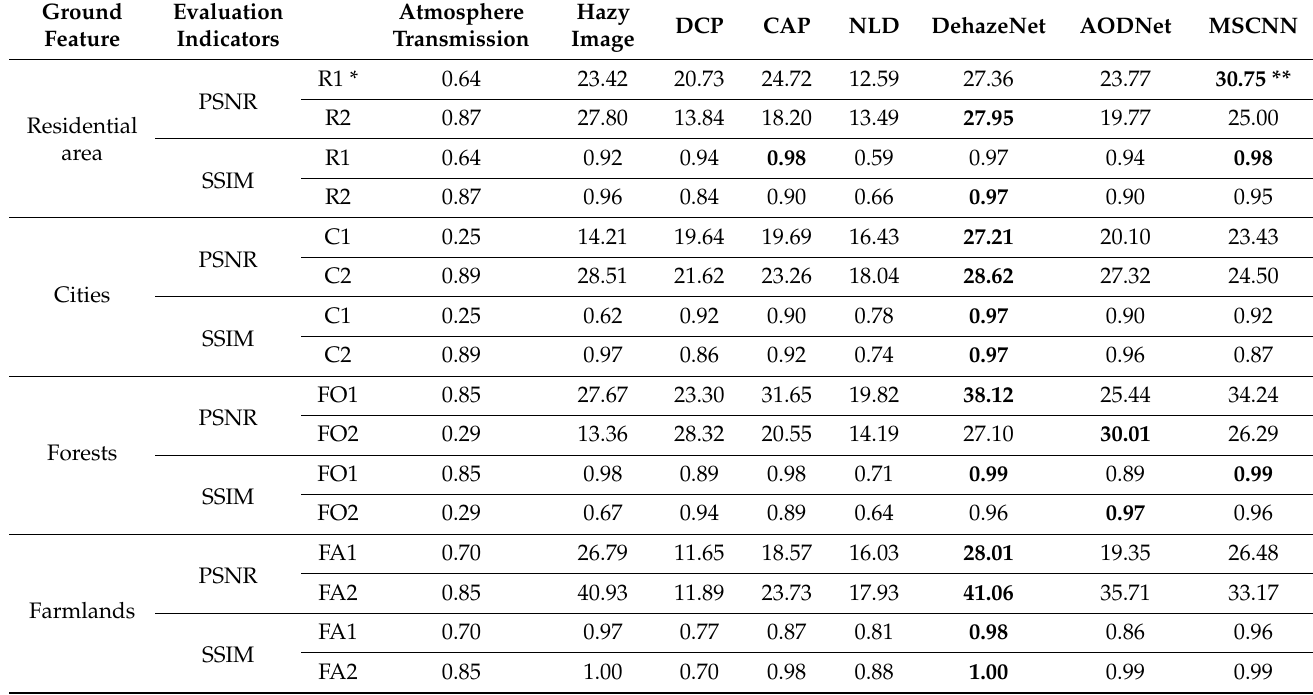
Table 1 lists the quantitative evaluation results of the traditional methods on hazy images and the dehaze results. In Table 1, the bold font indicates the best method. The testing dataset was labeled with R1, R2, C1, C2, FO1, FO2, FA1, and FA2. R1, R2 represent the two residential area image groups; C1, C2 represent the two city area image groups, FO1, FO2 represent the two forest area image groups; FA1, FA2 represent the two farmland area groups. Table 1. Quantitative evaluation results of different